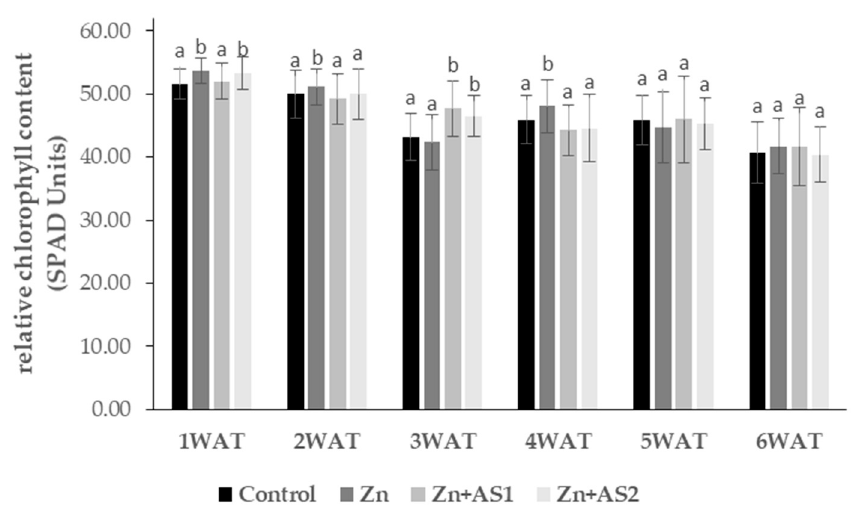
Figure 1. The effects of different foliar treatments (Zn, Zn+AS1, and Zn+AS2) on the relative chlorophyll content (SPAD units) in the youngest and fully developed leaves of maize 1,2, 3, 4, 5, and 6 WAT. n = 200 ± S.D. Lower case letters (a, b) show the significant differences among the treatment based on sampling time. WAT: week(s) after treatment.